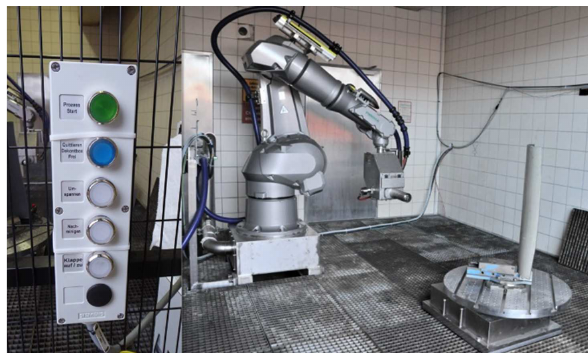
Fig. 10. RWE01 prototype evaluation in washing bay prior to operational release into decontamination room as RWE02. The scan head is designed as part of the blasting tool with a humid and watertight protective flap protecting the sensible laser and camera optics during decoating